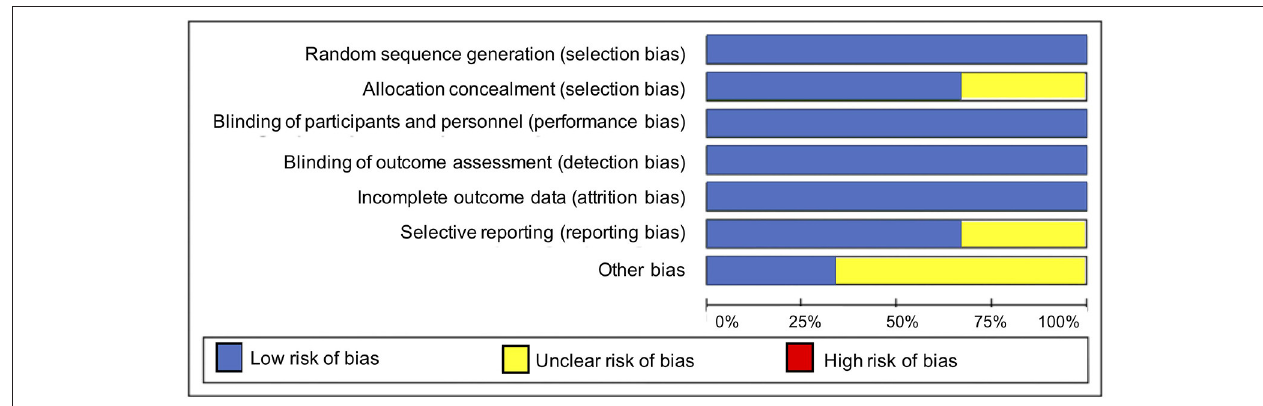
FIGURE 2 | Risk of bias graph.